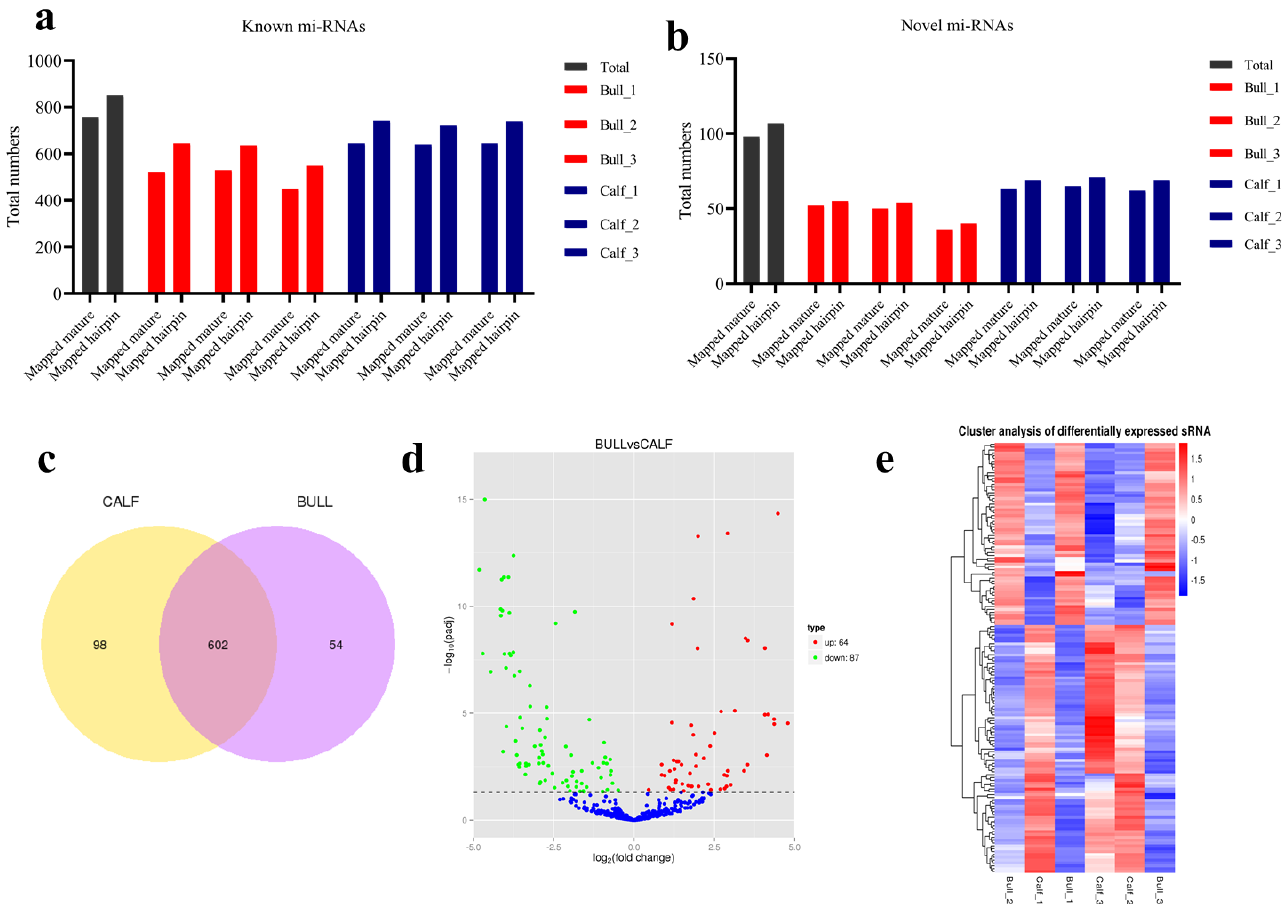
Figure 6. MiRNA expression patterns in bull and calf testes. ( a ) The known mapped miRNA identified in testes sample. ( b ) Novel mapped miRNAs were identified in corresponding samples. ( c ) Venn diagram shows the miRNA differential expression. The numbers in both left and right circles represent the total number of miRNAs, which are differentially expressed in each group; the overlapping part of the circles showed the total number of miRNAs expressed in both calf and bull groups. ( d ) The volcanic plot visualized the overall distribution of miRNAs and significant DE link genes. ( e ) Hierarchical diagram of differentially expressed miRNA. Red represents highly expressed miRNAs, while blue represents low – expressed miRNAs.